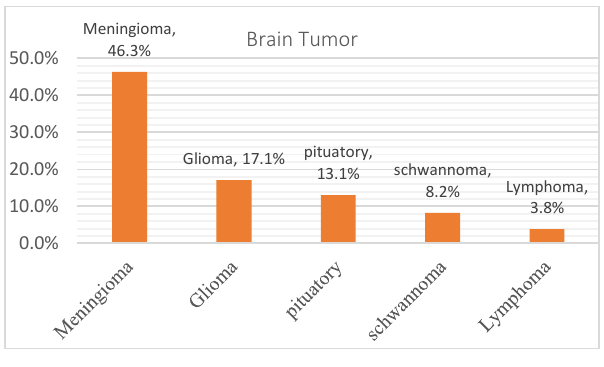
Fig. 1. Brain tumor in humans